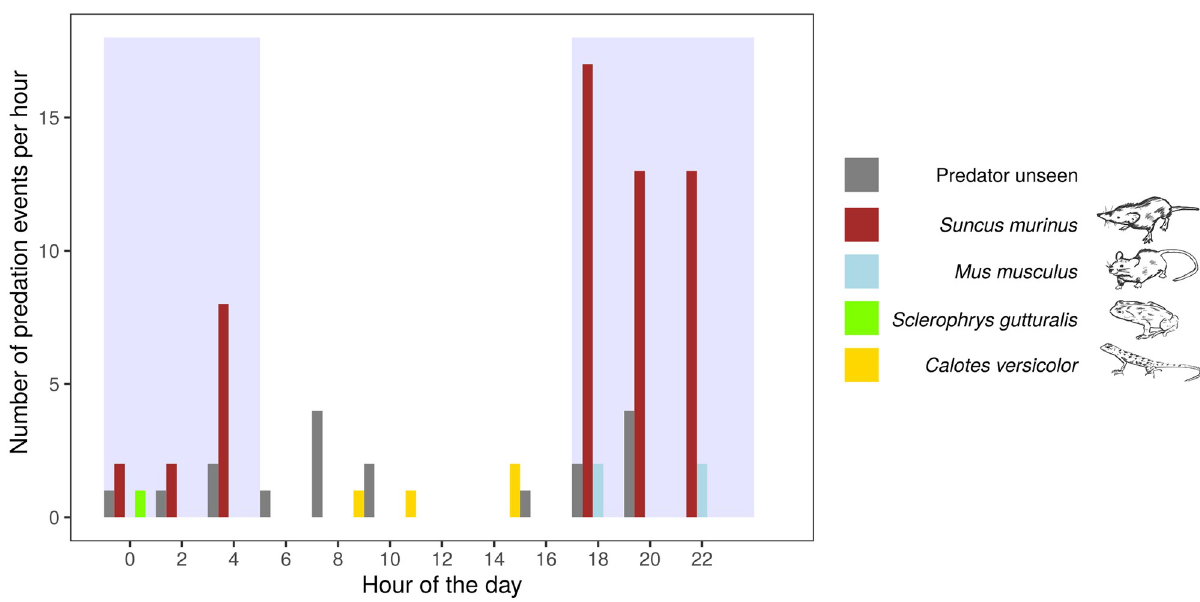
Fig 4. Number of predation events per hour for different predator species. The shaded area represents night